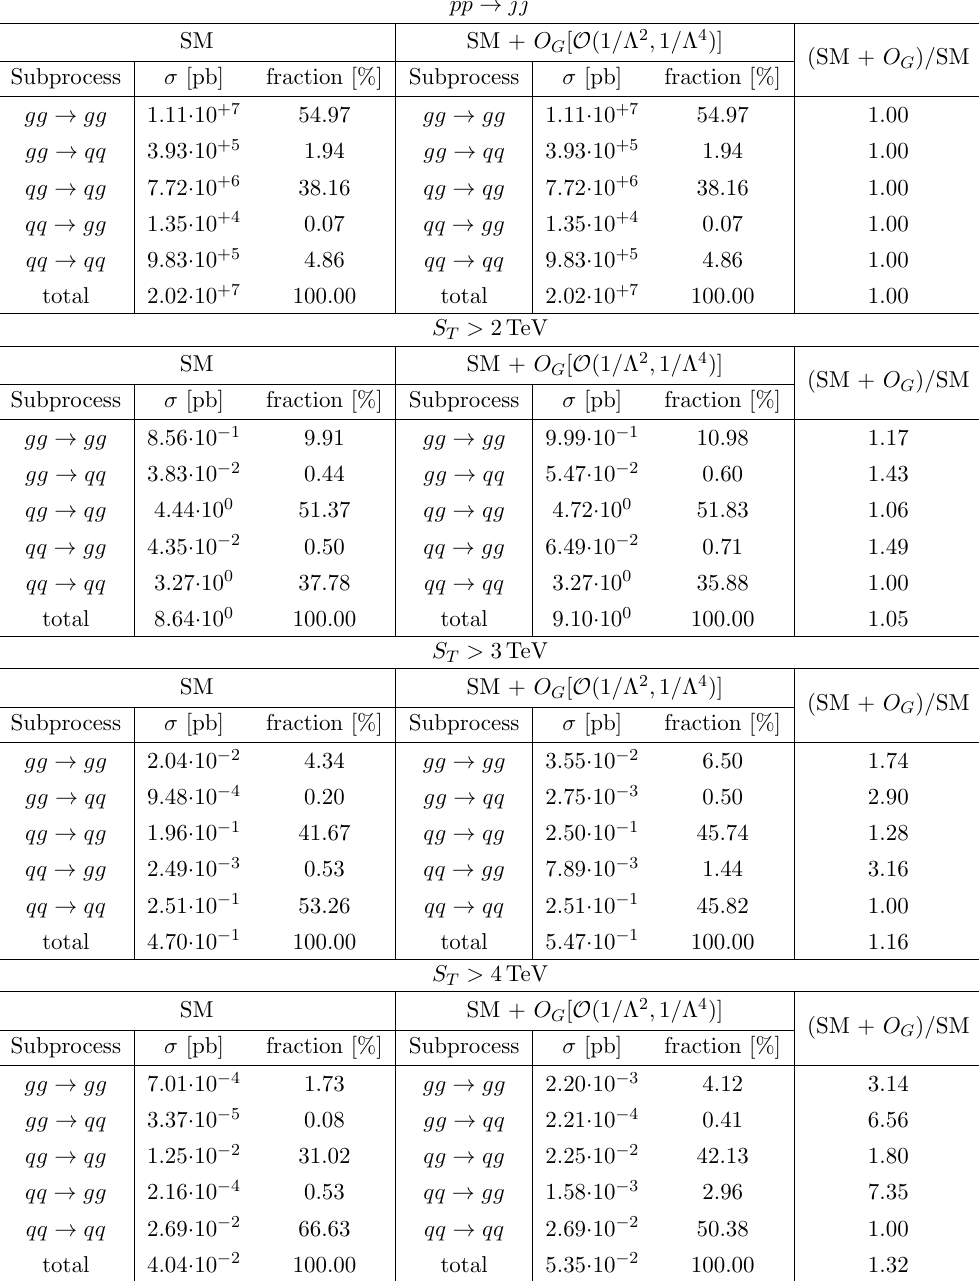
Table 3 . Contributions from the di(cid:11)erent partonic subprocesses contributing to di-jet production at LHC13 in the SM ( O (1 = (cid:3) 0 )) and when allowing at most one O G insertion in the